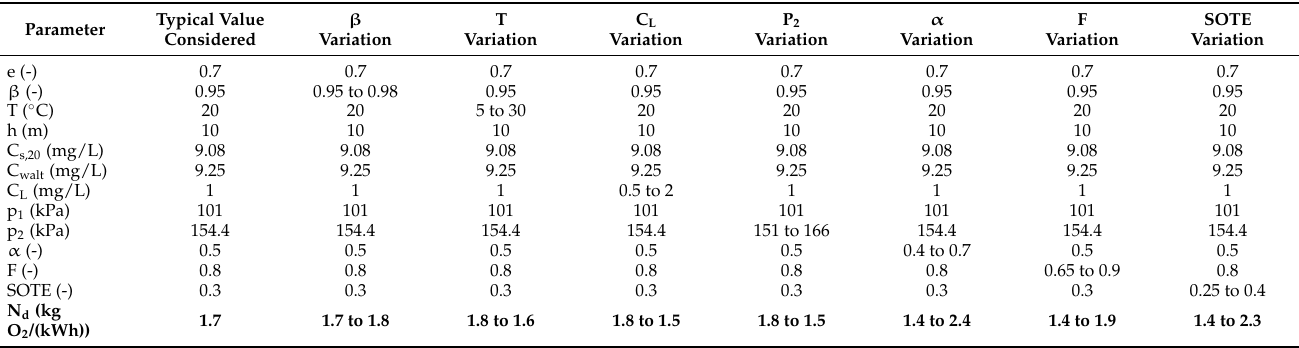
Table 13. The standard oxygen-transfer variation with each parameter of the air diffusor